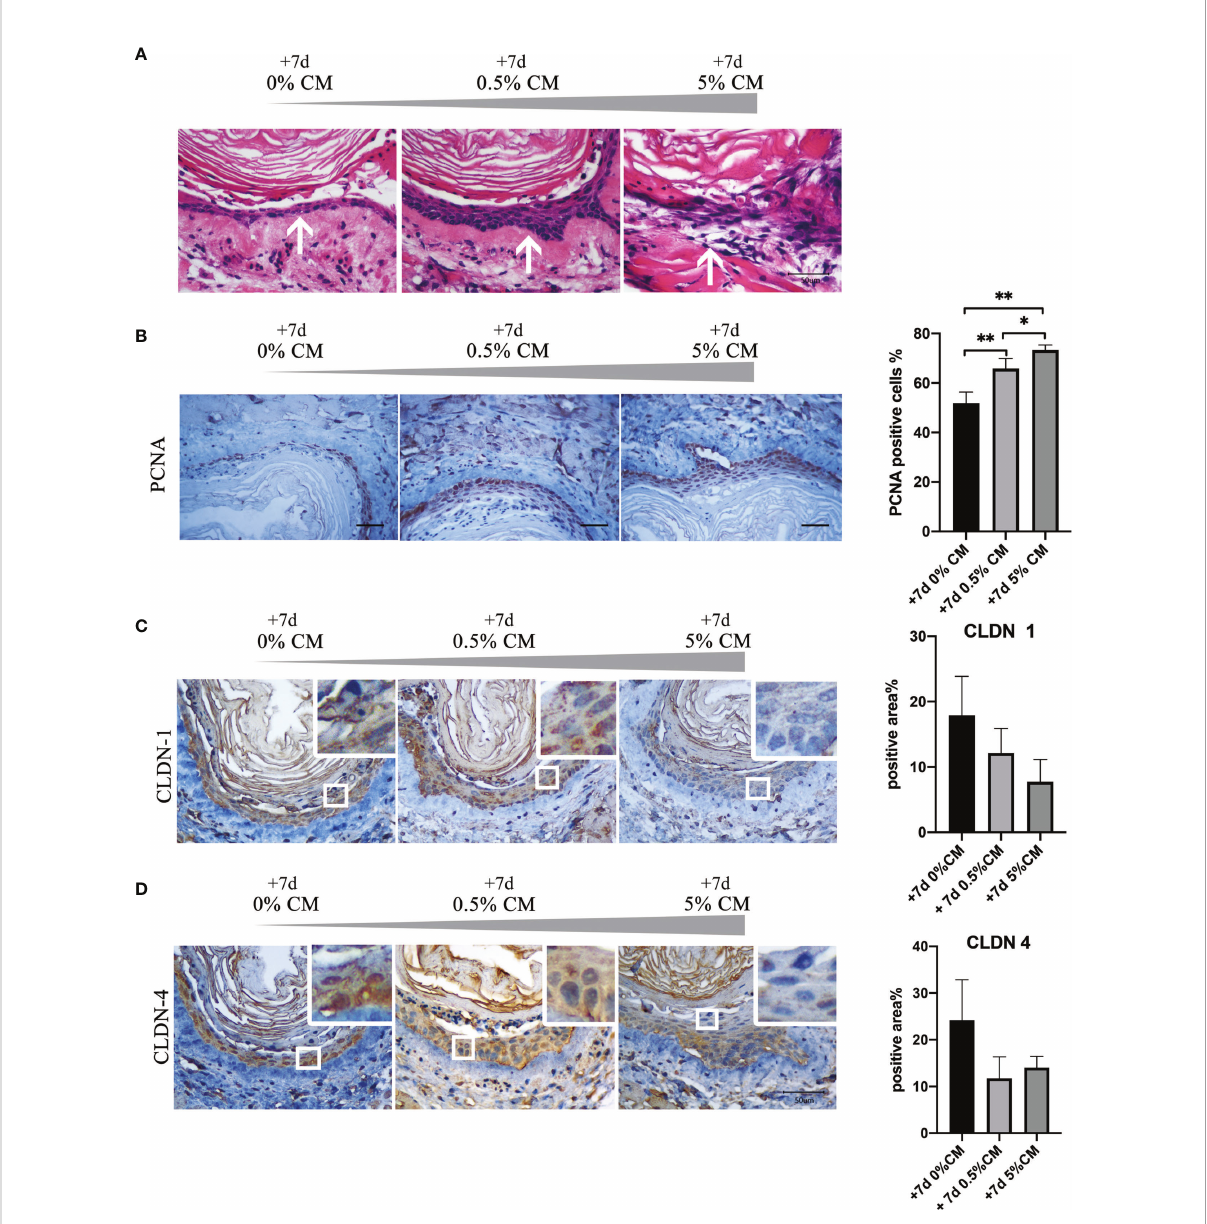
FIGURE 2 Addition of P. gingivalis cultured media to normal mouse esophagus in vitro for 7 days leads to malignant transformation. (A) The number of esophageal epithelial cell layers increased after treatment with 0.5% and 5% P. gingivalis cultured media and the cell arrangement was disordered in the 5% CM group (white arrows). (B) The rate of PCNA-positive cells was signi fi cantly in 0.5% CM and 5% CM groups compared with the control group. (C, D) The expression of CLDN1 and CLDN4 was down-regulated gradually as the concentration of P. gingivalis cultured media increased compared with the control esophageal epithelium. Scale bar: 50 m m. * P < 0.05; ** P <